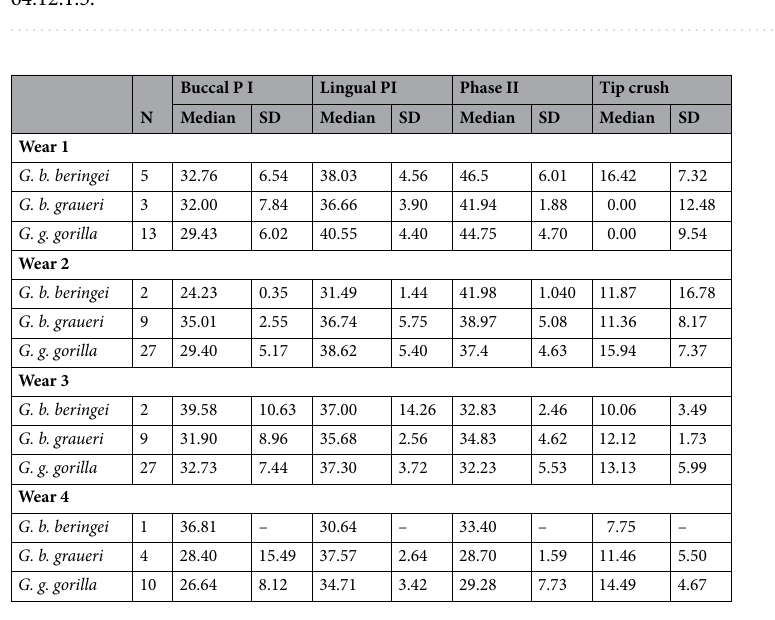
Table 2. Summary statistics (median and SD) of wear facet inclinations divided by wear stages.